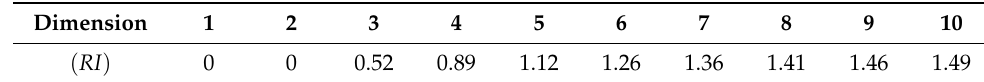
Table 4. Random consistency